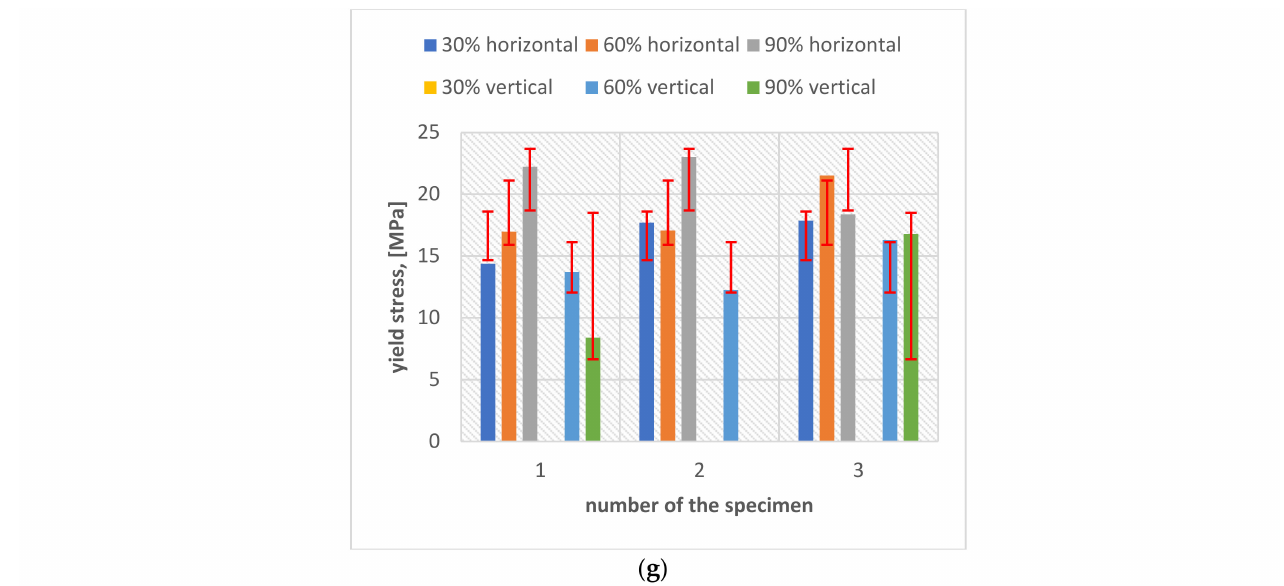
Figure 13. Influence of filling density of specimens printed in horizontal and vertical orientations with COLORFILL filament on mechanical properties (Young’s modulus E, tensile strength σ m , yield strength σ 0 ): ( a ) comparison of all results obtained in laboratory tests, specimens printed in a horizontal orientation; ( b ) comparison of all results obtained in laboratory tests, specimens printed in a vertical orientation; ( c ) comparison of averaged values, specimens printed in a horizontal orientation; ( d ) comparison of averaged values, specimens printed in a vertical orientation; ( e – g ) all obtained results, with error bars calculated as standard